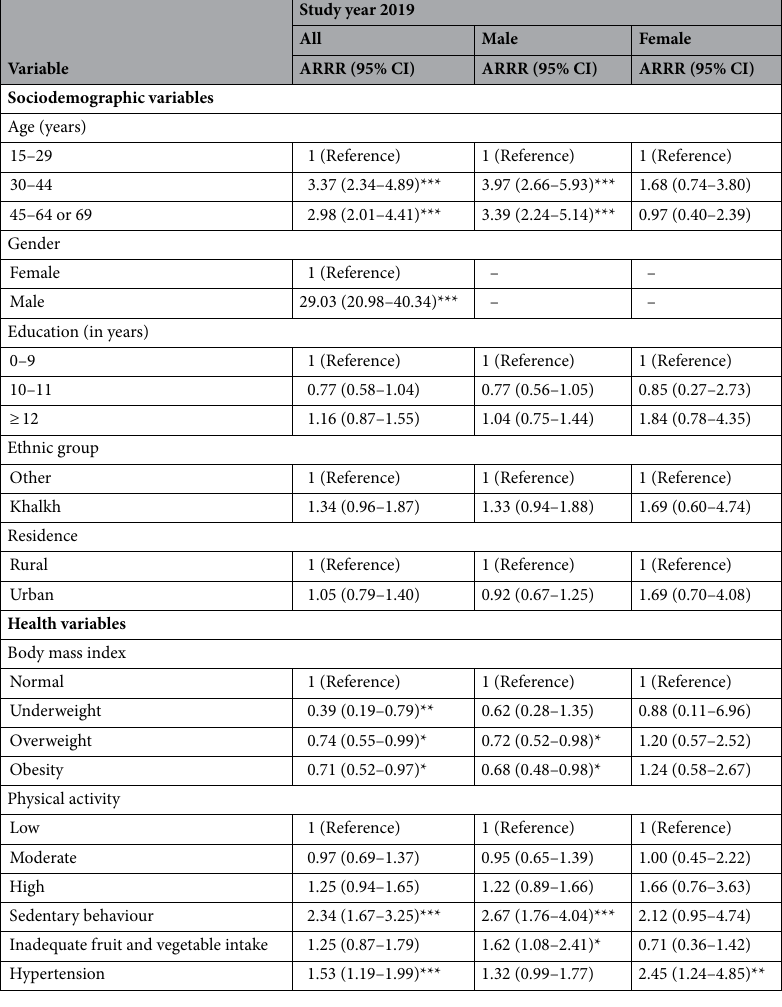
Table 18. Associations with current tobacco use and current heavy drinking (with non-current tobacco and non-current heavy drinking as reference category) among 15 years and older individuals in Mongolia,